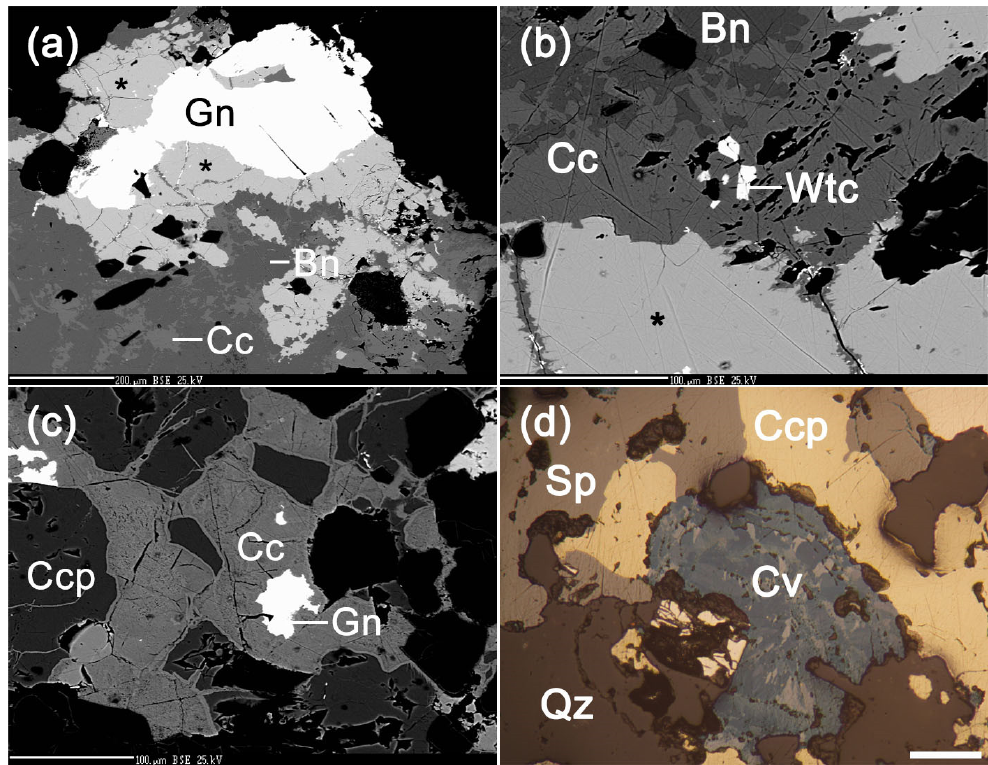
Figure 8. Plane-polarized reflected light photomicrographs and back-scattered electron images showing the unnamed mineral and copper minerals from quartz-precompact copper: intergrowth between the unnamed mineral, chalcocite, bornite, and galena ( a ); intergrowth between the unnamed mineral, chalcocite, and bornite; wittichenite is present as small inclusions in the chalcocite ( b ); secondary chalcocite with galena inclusions that replace and cement chalcopyrite ( c ); secondary covellite substitutes the intergrowth between chalcopyrite and sphalerite ( d ). Gn—galena; *—unnamed mineral; Cc—chalcocite; Bn—bornite; Wtc—wittichenite; Ccp—chalcopyrite; Sp—sphalerite; Cv—covellite; Qz—quartz. Scale bars on the photomicrographs are 100 μm. Covellite is an accessory mineral formed by the alteration of primary copper sulfides.